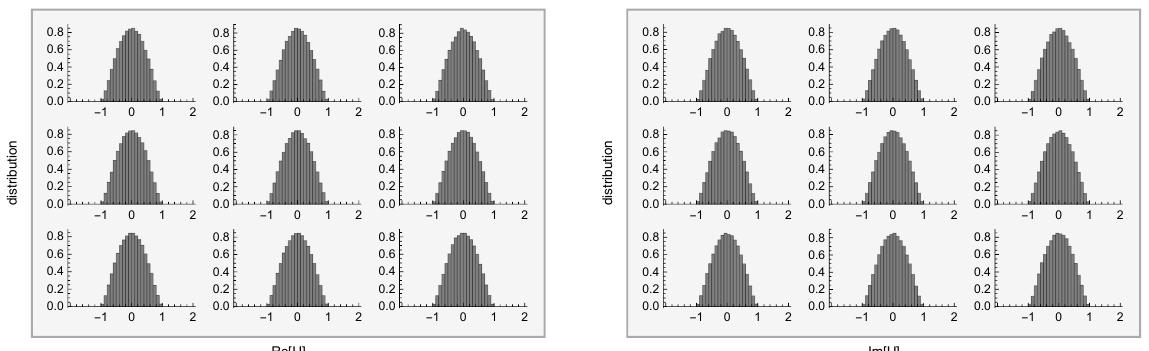
Figure 3. Distributions of real and imaginary parts of the entries of Haar-distributed U